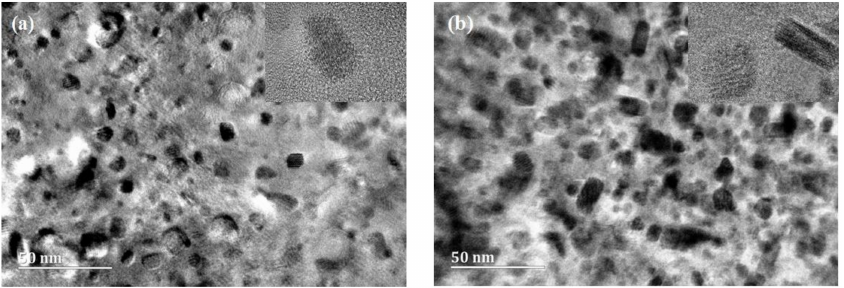
Figure 4. TEM image of the fine secondary phase particles in grain experienced after different CT temperatures: ( a ) 25 ◦ C and ( b ) − 120 ◦